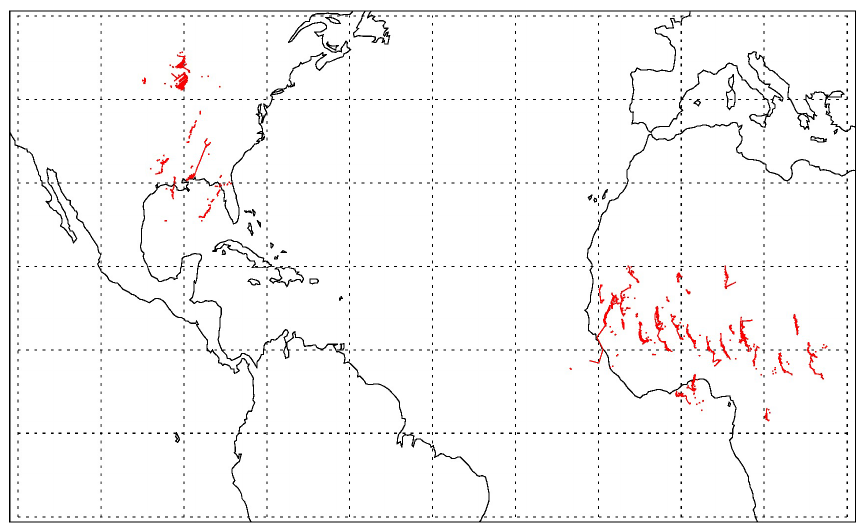
Figure A1. The geographic distribution of the 47 squall line cases that are selected. Red dots are the location of the identified deep convective center (i.e., maximum PR sfc while PR sfc > 25mm/h threshold) on each KuPR scan. Each scan swath is then aligned against this center location (setting as 0) to make the composites shown in Figs. 9 and A2.